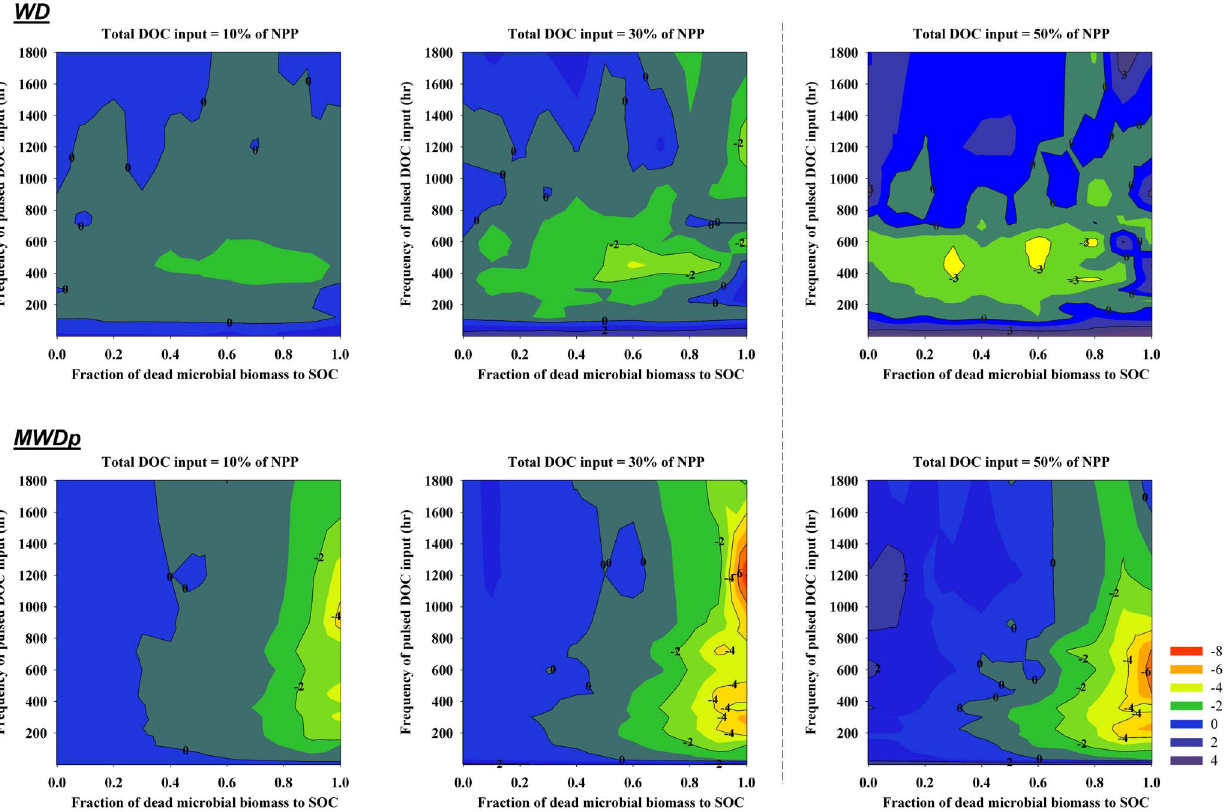
Figure 5. The simulated impacts of 3 6 C warming on priming effects (g OC m 2 2 yr 2 1 ) associated with different amounts of total DOC input at each site (WD and MWDp) as affected by different frequencies and intensities of DOC input (Y axis) and the quality of microbial necromass (as represented by the fraction of microbial necromass apportioned to SOC). The simulated impacts are indicated as the differences between the simulations with warming and simulations without warming.